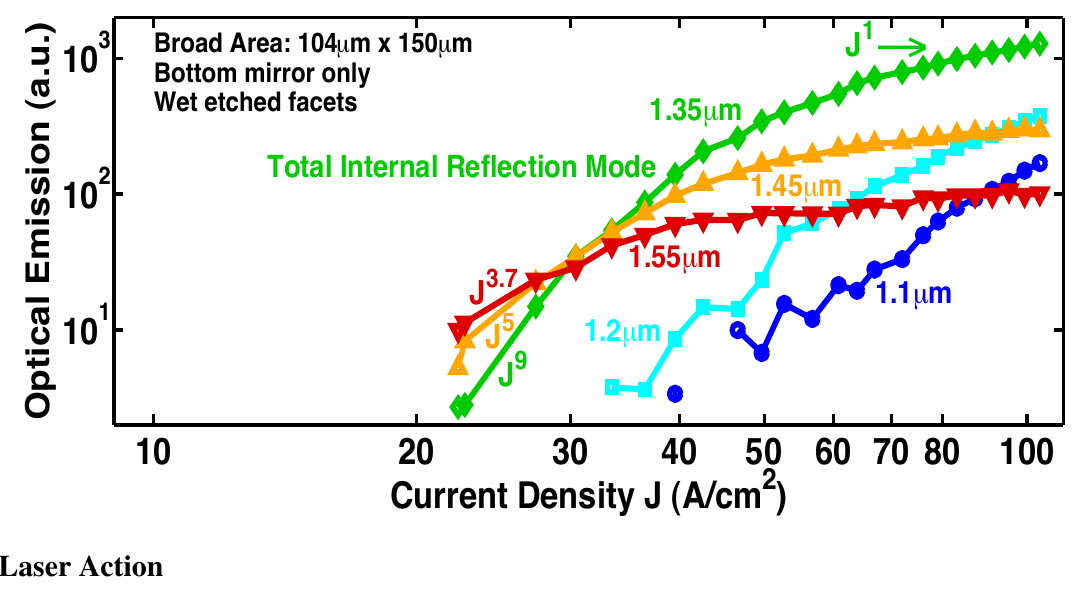
Figure 14 . Room-temperature L-I curves [5] measured in cw-mode from the same pixel on Sample G at different wavelengths in a single-pass geometry. At current densities greater than 65 A/cm 2 , the optical-emission at 1.35 µ m becomes proportional to the first power of J, and the longer wavelength (e.g, 1.45 µ m and 1.55 µ m) optical-emission clamps at a constant value. The latter indicates that, at these injection levels, all the additional carriers supply the optical emission into the low-loss total-internal-reflection mode, rather than the longer wavelength lossy modes. These two observations indicate gain pinning and single-pass laser